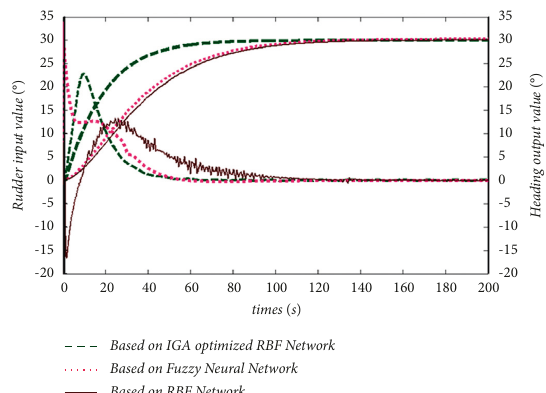
Figure 7: Result of heading output and rudder input in the comparison experiment.